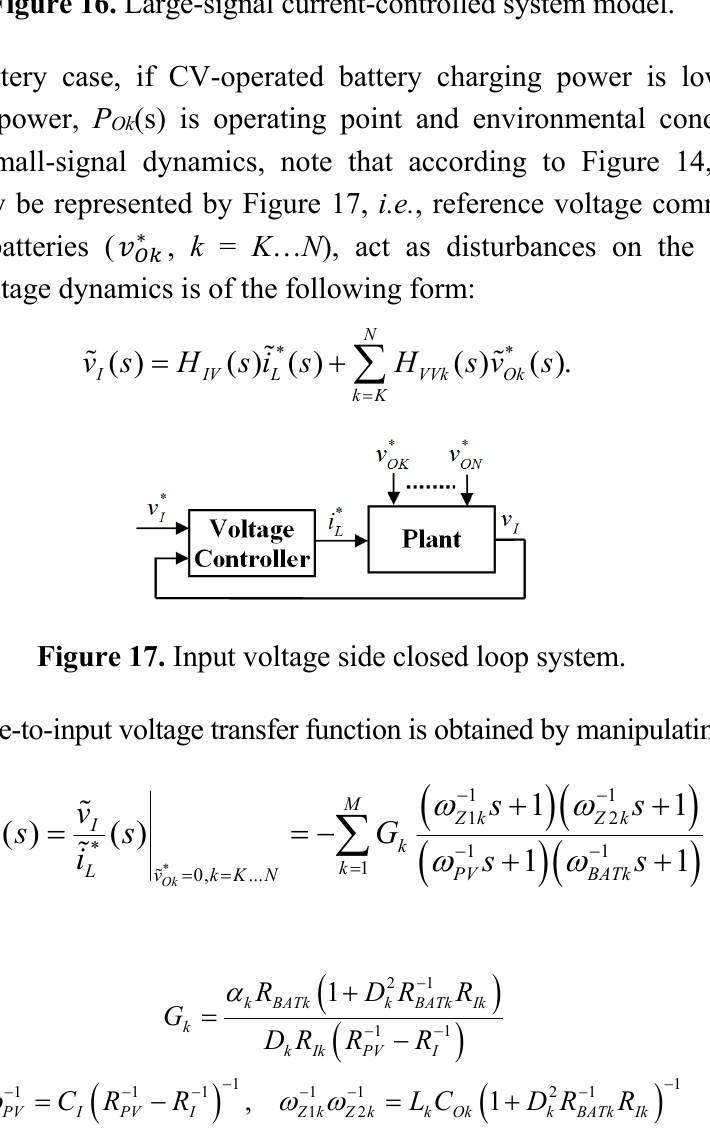
Figure 16. Large-signal current-controlled system model.